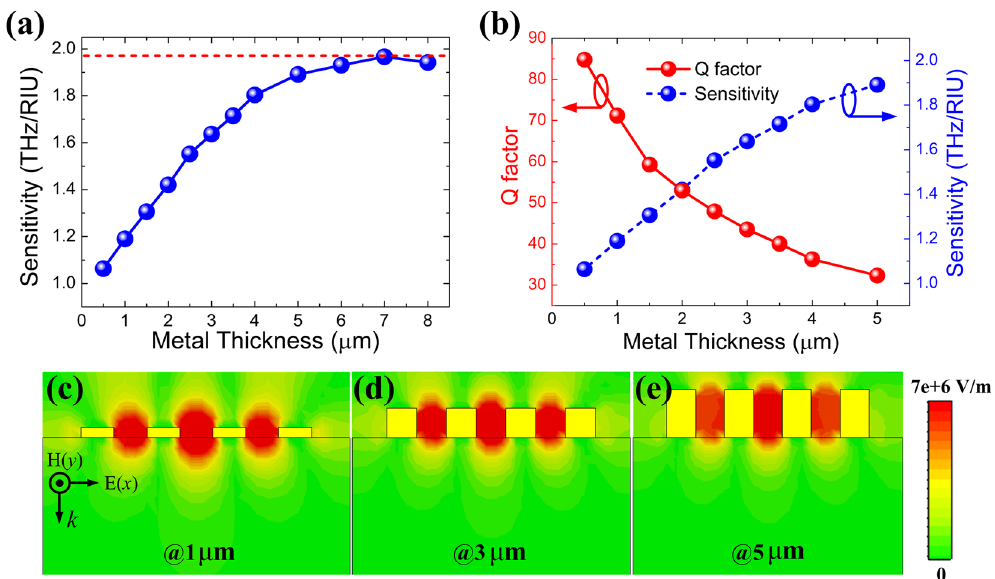
Figure 6. ( a ) Frequency sensitivity with varying the metal thickness of the MMs structure, the red dotted line is the maximum sensitivity. ( b ) The Q factor and sensitivity varied with the metal thickness. ( c , d ) Electric field intensity (| E x |) distributions of the sharp resonance mode with the metal thicknesses of 1 μ m, 3 μ m and 5 μ m,